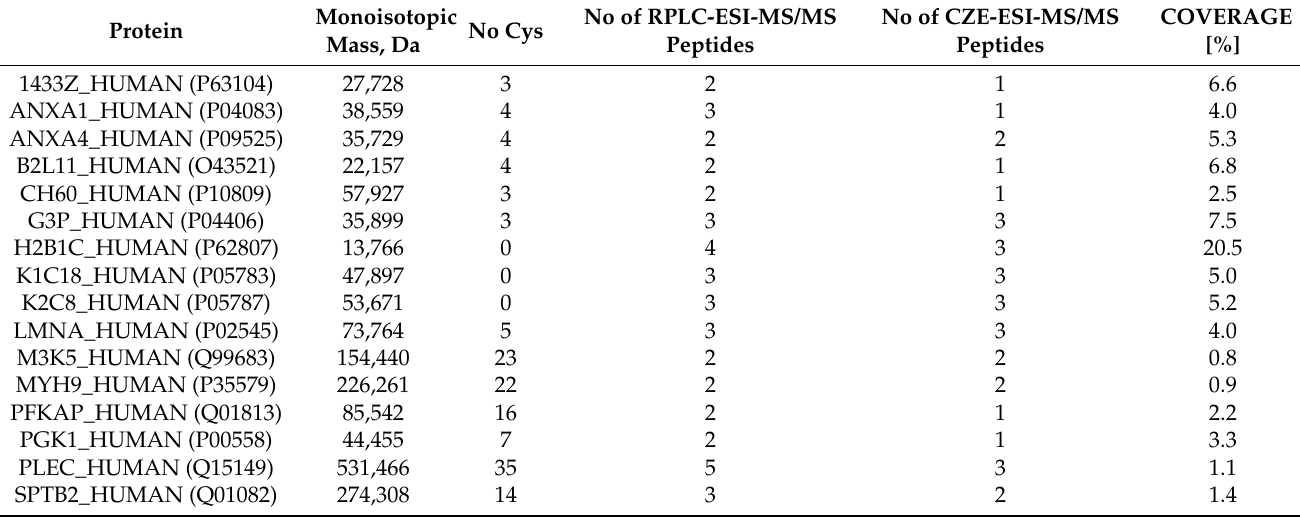
Table 1. The list of proposed identities for proteins based on LC-MS/MS results for tryptic digests for which signal intensity significantly changed for cells exposed to auranofin. The coverage describes the degree to which the amino acid sequence in peptides is defined relative to the protein total sequence. See Table S1 for detailed